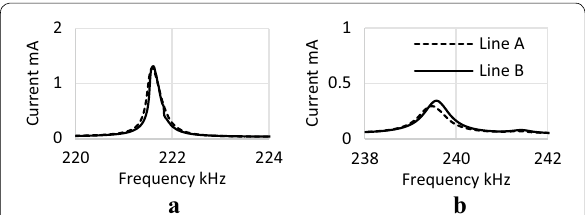
Fig. 8 Frequency characteristics of the current: a cubic bulk stator and b cubic bronze stator. Lines A and B are well accorded in the two